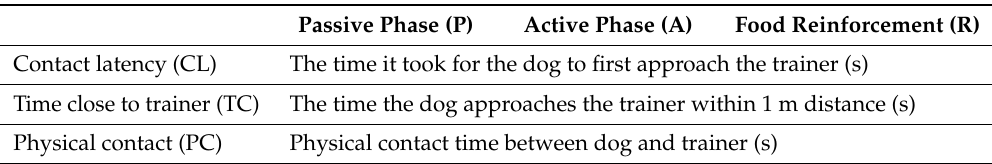
Table 1. Categories for evaluating social behavior in dogs.